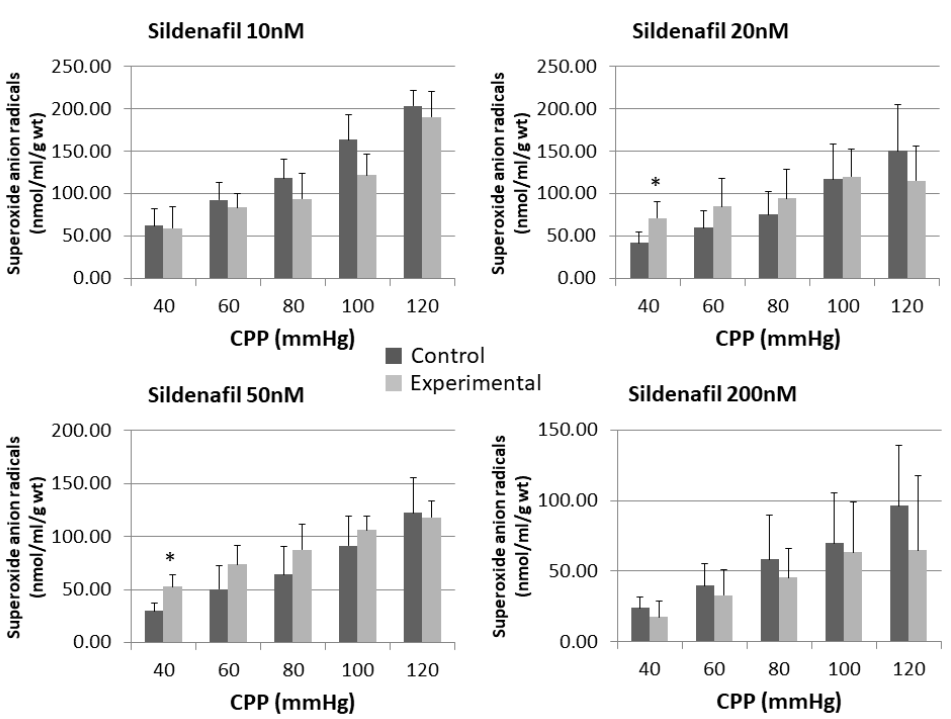
Figure 5. Influence of different sildenafil doses on the dynamics of released superoxide anion radical (O 2 − ) in the isolated rat heart. * p < 0.05, Mixed between-within subject ANOVA; Tukey’s HSD. The perfusion with a combination of L-NAME and sildenafil at doses of 10 nM, 20 nM and 50 nM generated lower O 2 − values in comparison to control at all pressures. The opposite could be seen for sildenafil 200 nM + L-NAME group, where statistically signifi- cant higher O 2 − release was reached at CPP of 80 mmHg (13.23 ± 8.09 vs. 33.19 ± 8.30) and 120 mmHg (24.99 ± 11.41 vs. 50.41 ± 10.36).